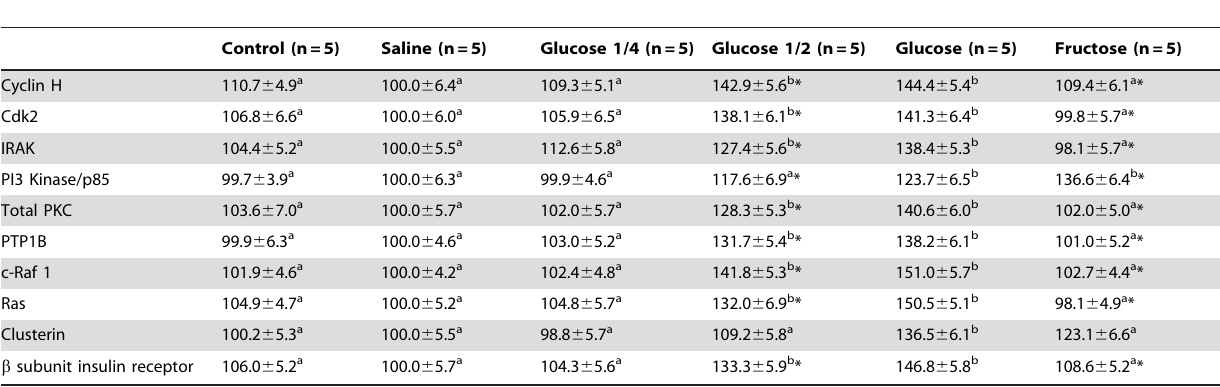
Table 3. Relative increase in serine phosphorylation levels of selected skeletal muscle proteins in rats subjected to an oral glucose or fructose